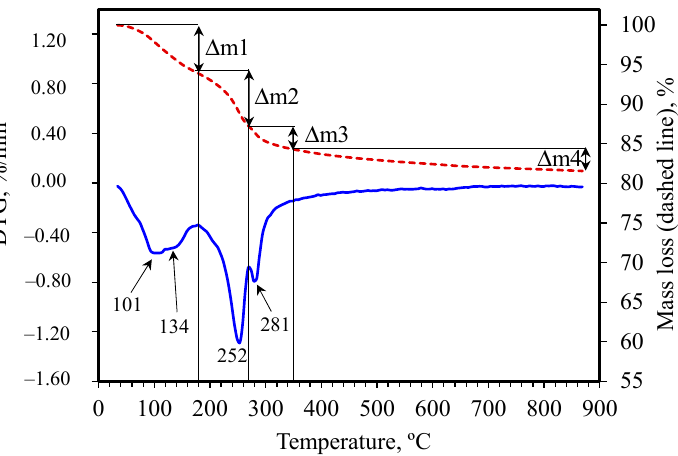
Figure 9. Exemplary TG and DTG curves for G0 sample and Δ m1– Δ m4—explanations in the text.